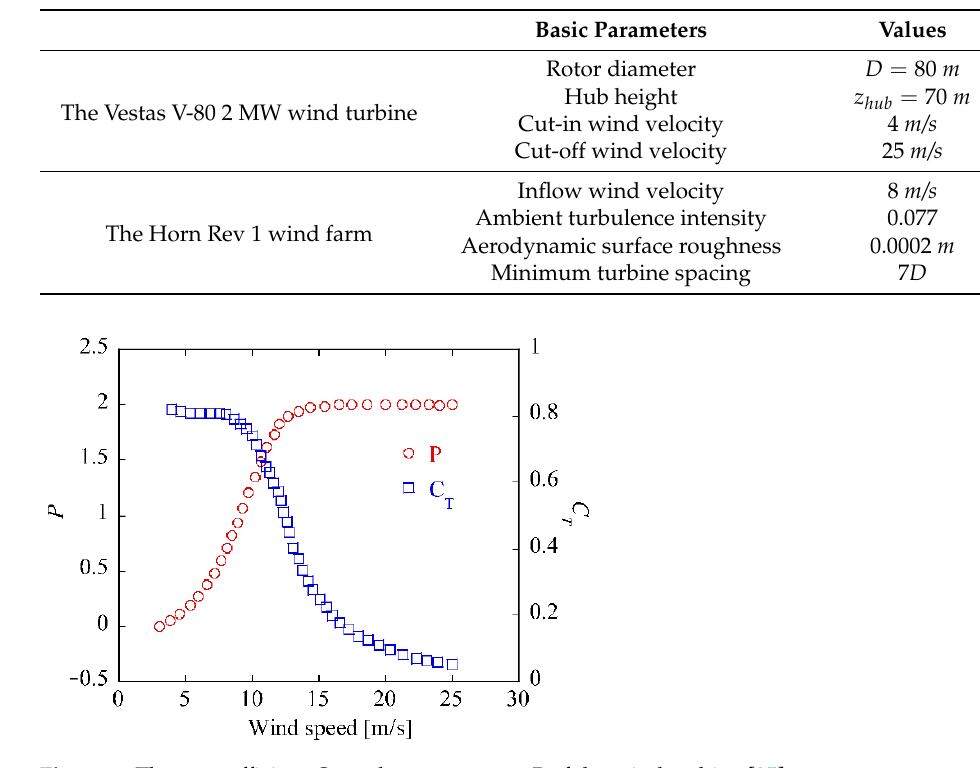
Figure 7. Thrust coefficient 𝐶 𝑇 and power curves P of the wind turbine [35].